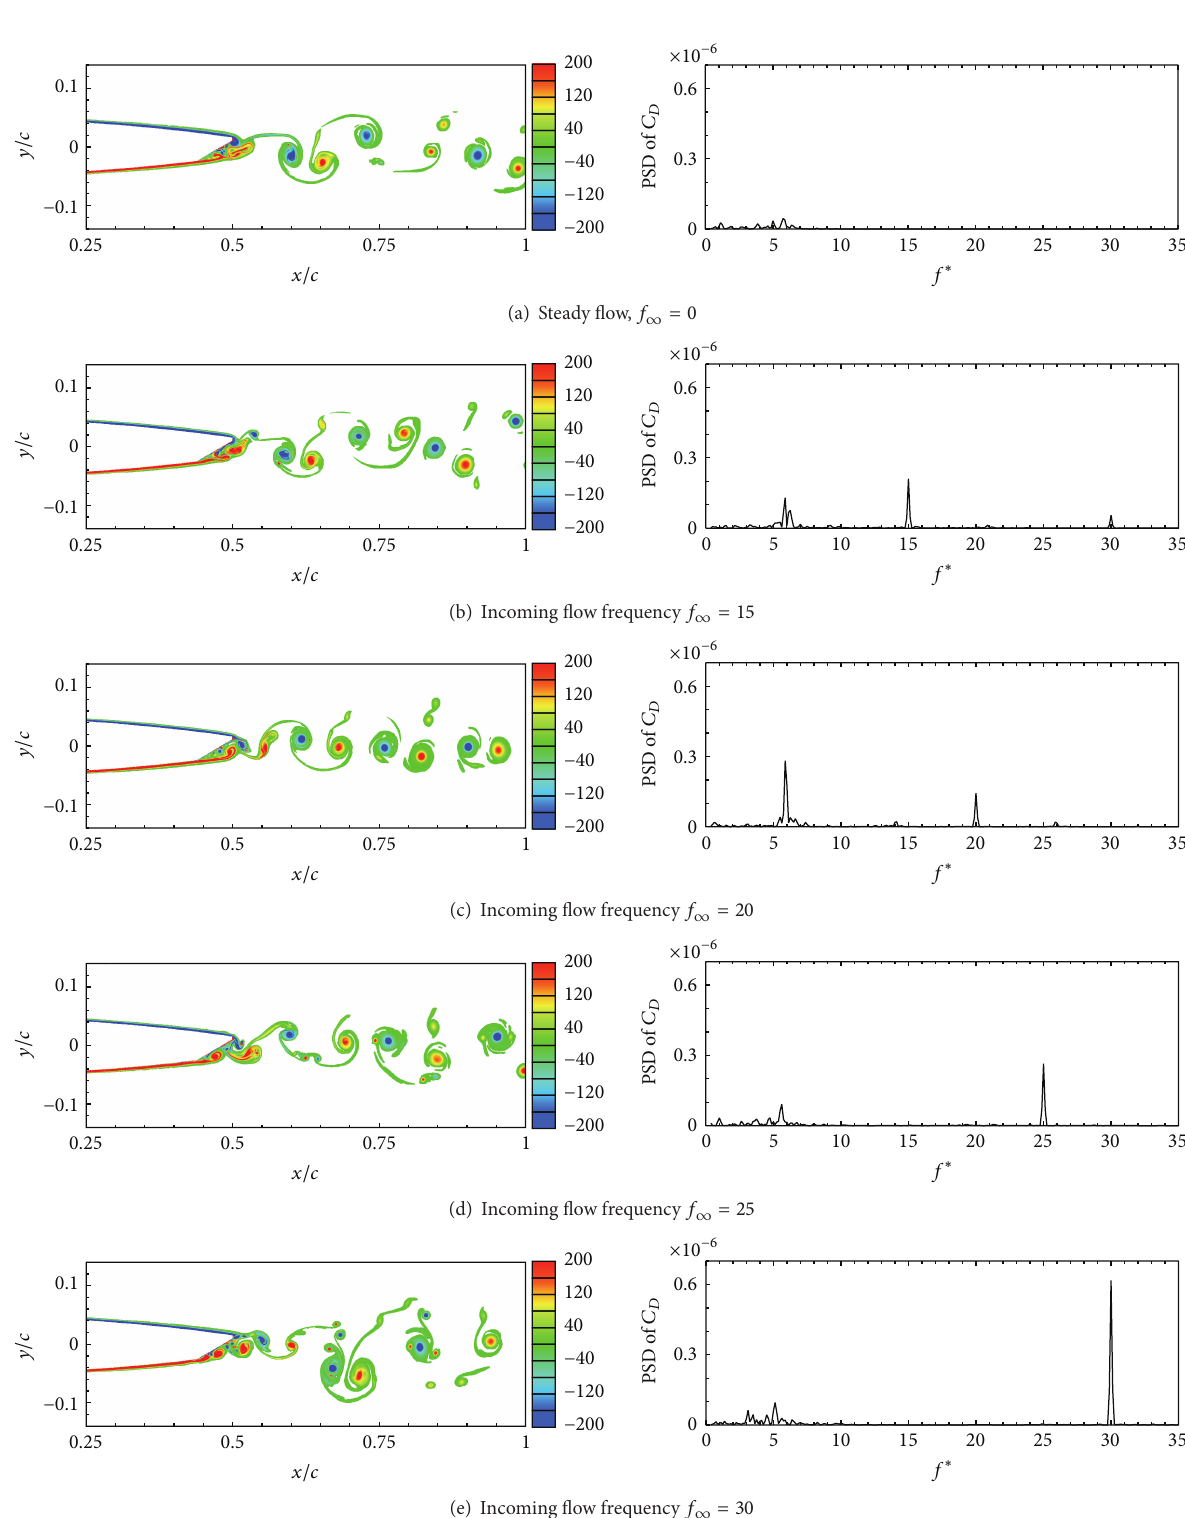
Figure 9: Effect of the incoming flow frequency on vortex shedding from a beveled trailing edge of 𝛽 = 60 ∘ at 𝑓 ∞ = 15 , 20, 25, and 30. The contour indicates the instantaneous vorticity distribution at 𝑇 = 10 , and the power spectral density (PSD) is calculated from the drag coefficients in the range 𝑇 = [3,10]